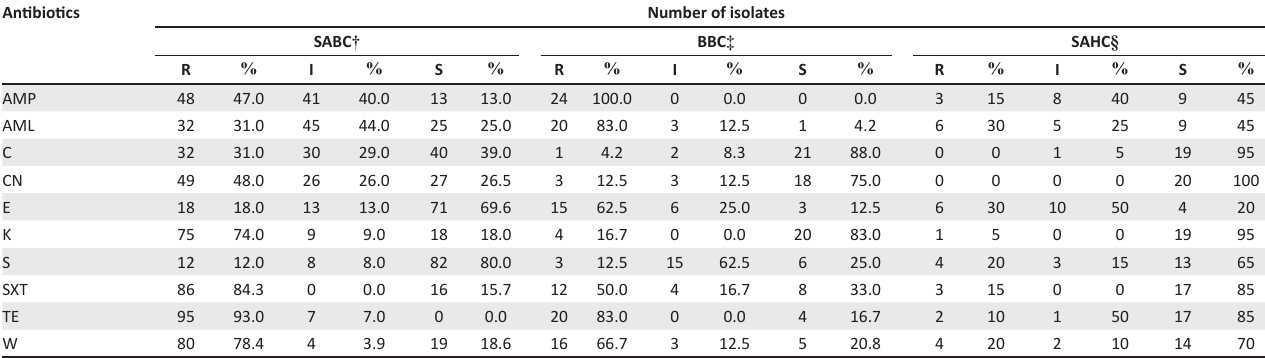
TABLE 5: Antimicrobial susceptibility tests on Salmonella isolates of different origins. Antibiotics